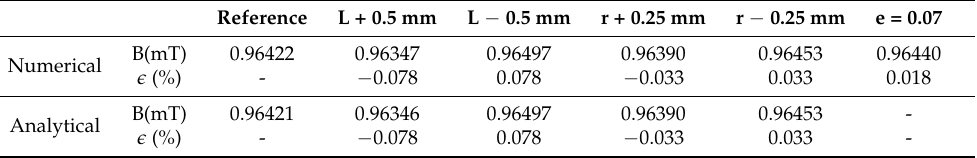
Table 3. Impact of the geometrical variations of the solenoid geometry on the on-axis magnetic field with numerical and analytical